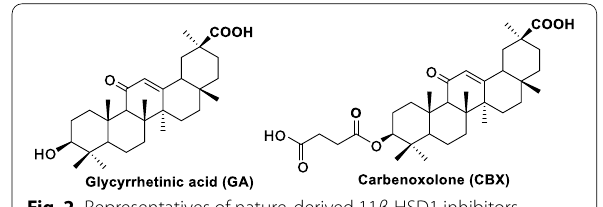
Fig. 2 Representatives of nature‑derived 11 β- HSD1